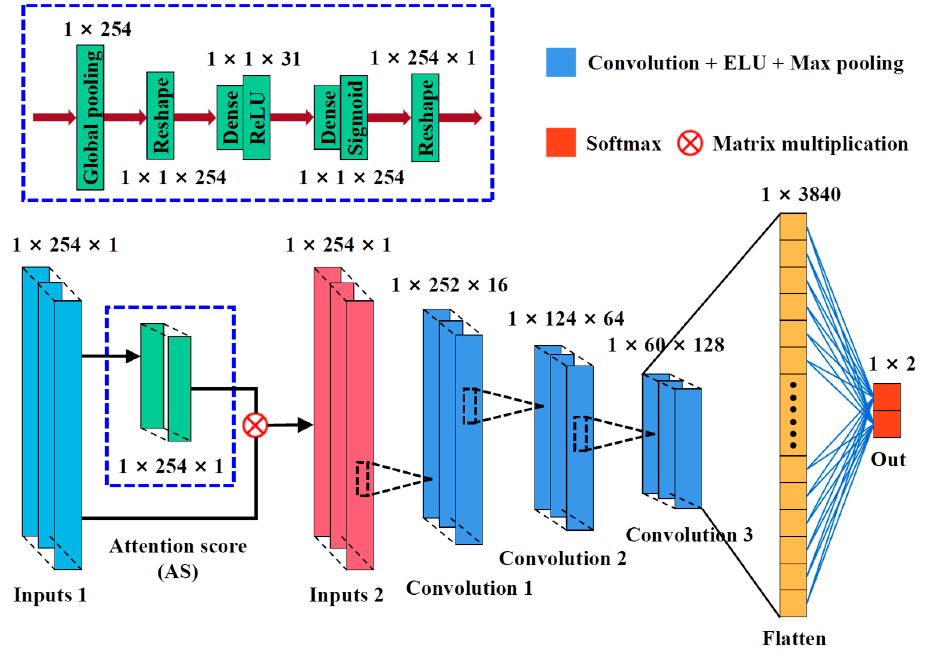
Figure 6. Architecture of CNN-ATM module.